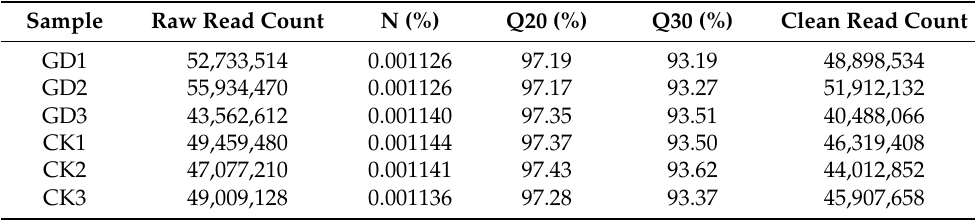
Table 3. Raw data statistics and filtering. Table 4. Summary of transcript